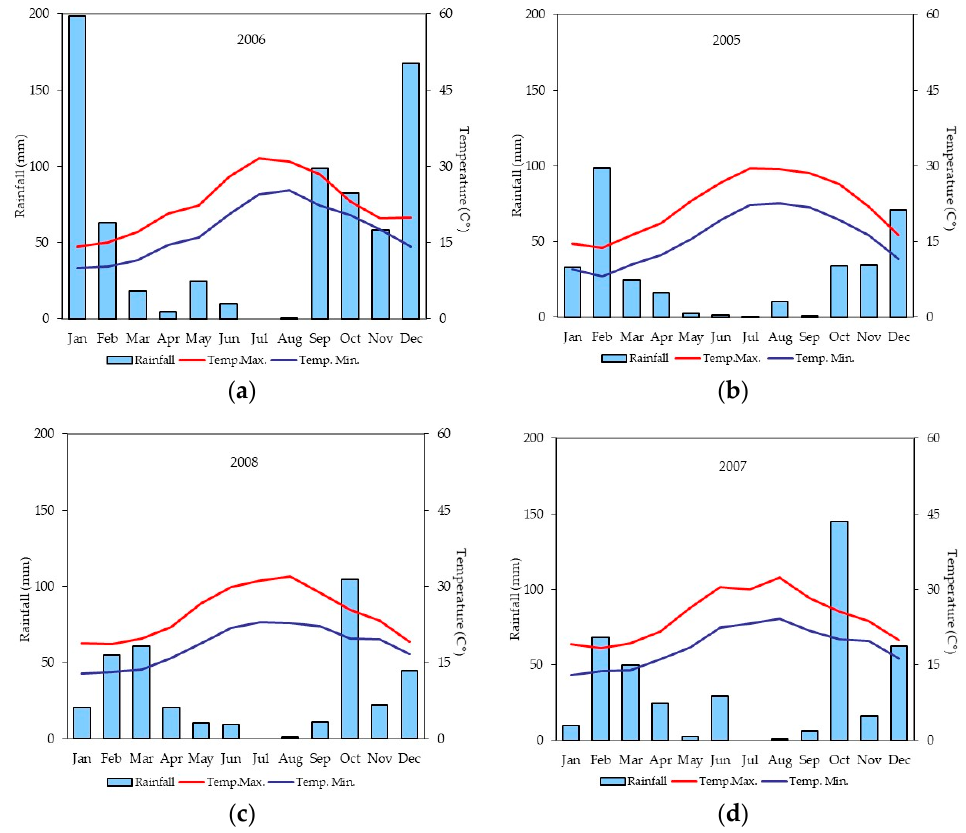
Figure 3. Rainfall and air temperature trends during the test period in the experimental area. Graph ( a ) refers to 2005, graph ( b ) refers to 2006, graph ( c ) refers to 2007 and graph ( d ) refers to 2008. Rainfall levels during the 4 test years were not always typical of the test environ- ment. In 2005, the year the caper plants were planted in the test field, precipitation depth was consistent with the test environment, whereas in 2006, it was high at 725 mm of rain. In 2007, when phenological and production measuring began, rainfall levels were approximately 100 mm greater than typical of the test environment (414.40 mm). In 2008, the final test year, rainfall was consistent with the test environment (359.00 mm). Rainfall events have always been concentrated mostly in January and in the months between September and December. Average minimum air temperatures (2005:15.80 ◦